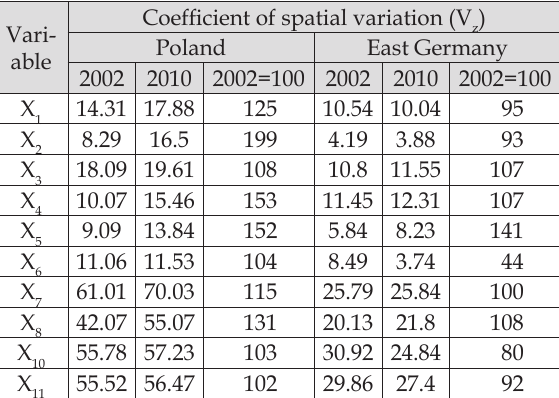
Table 4. Coefficient of spatial variation (%) in Poland